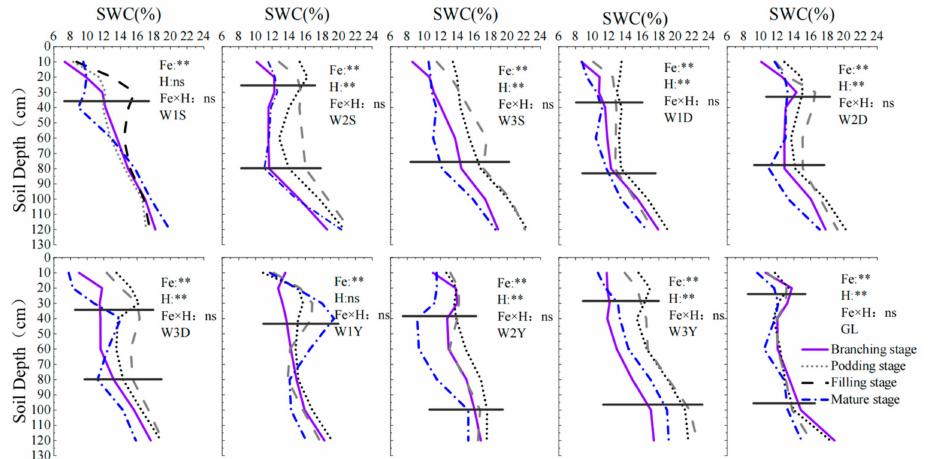
Figure 6. Vertical variation of soil water content during soybean growth period. Note: ** is highly significant ( p < 0.01); ns is insignificant correlation ( p > 0.05). Fe is the fertility period and H is the soil depth.